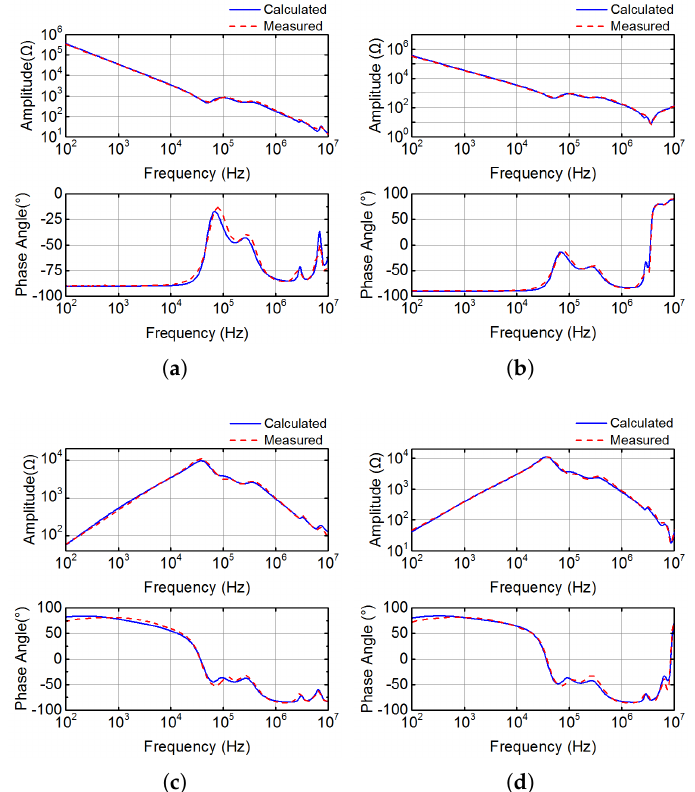
Figure 7. Comparisons between calculated and measured impedances of the motor: ( a ) CM impedance without wire, ( b ) CM impedance with wire, ( c ) DM impedance without wire, ( d ) DM impedance with